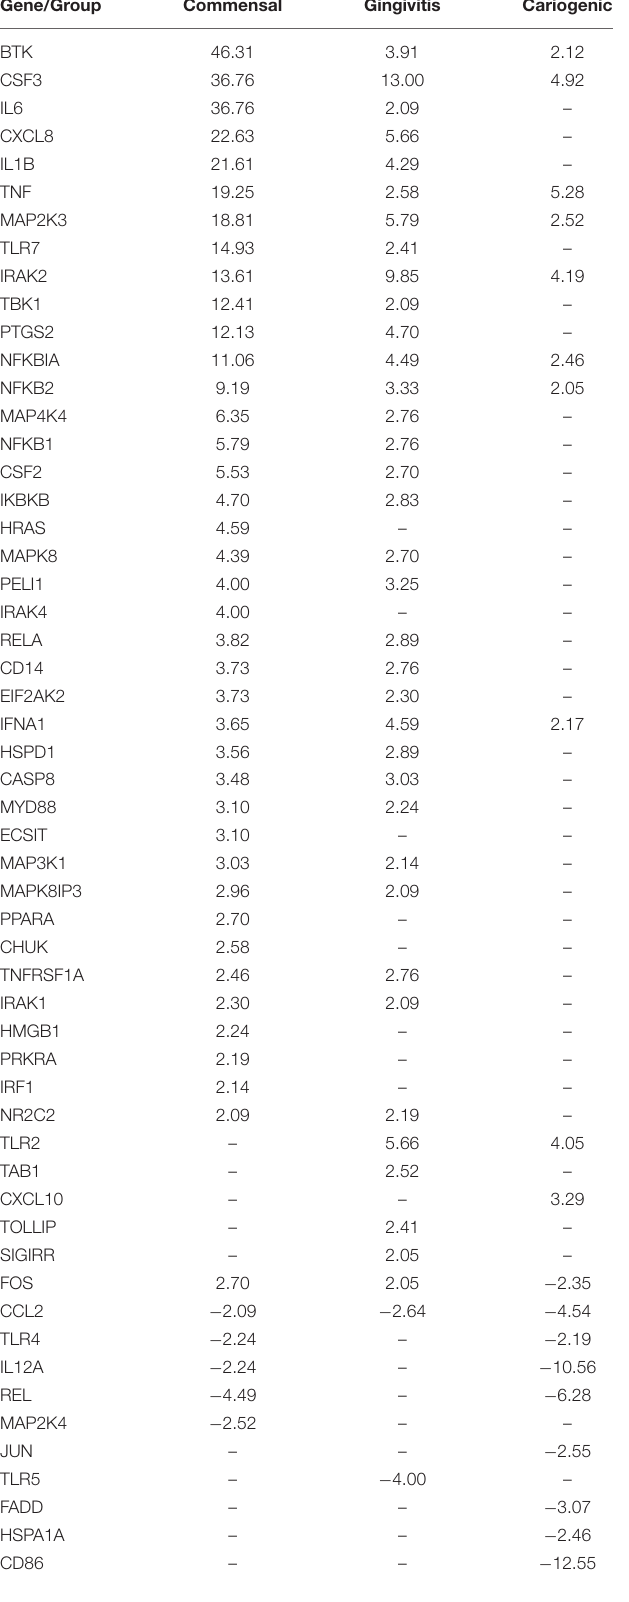
TABLE 1 | Genes up/down-regulated more than 2-fold. Gene/Group